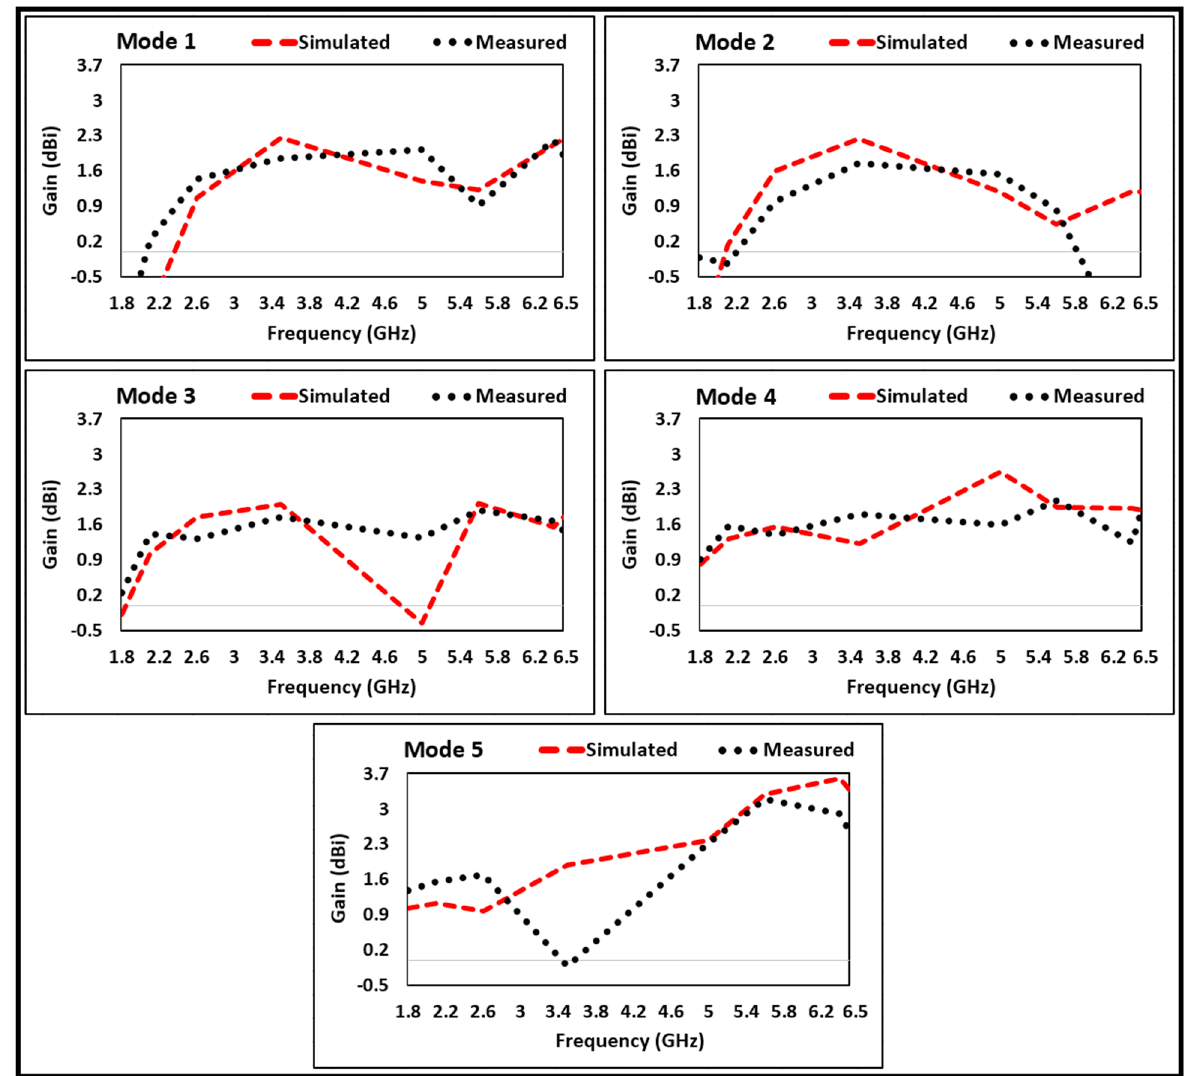
Figure 8. Comparison of simulated and measured gain. Table 3. Summary of half power beamwidth and main lobe